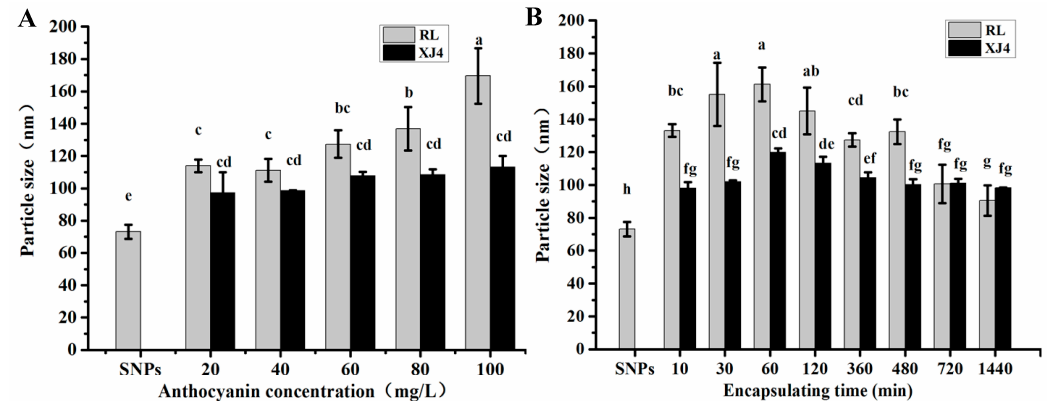
Figure 4. Size of CSNPs under various anthocyanin concentrations and encapsulating times. Within